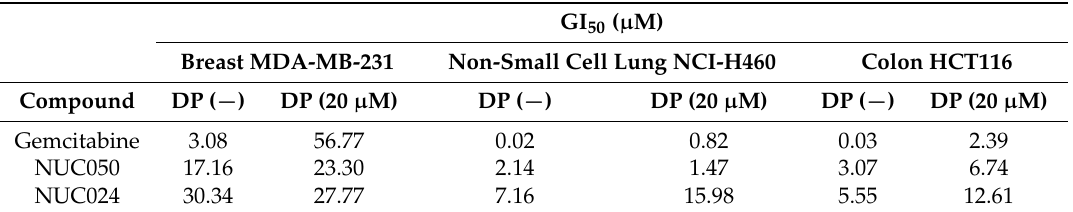
Table 2. Comparison of GI 50 of gemcitabine, NUC050 and NUC024 in the presence or absence of dipyridamole (DP).